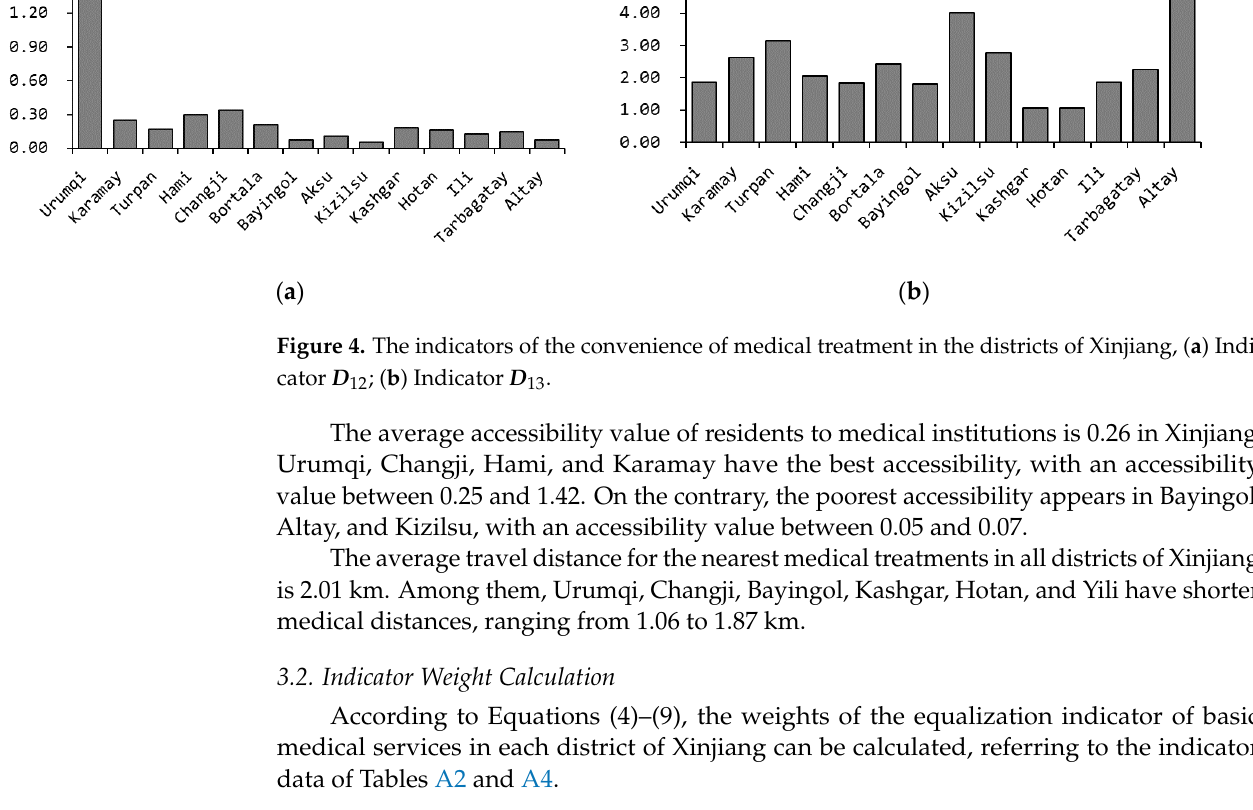
Table 5. Standardized decision matrix.